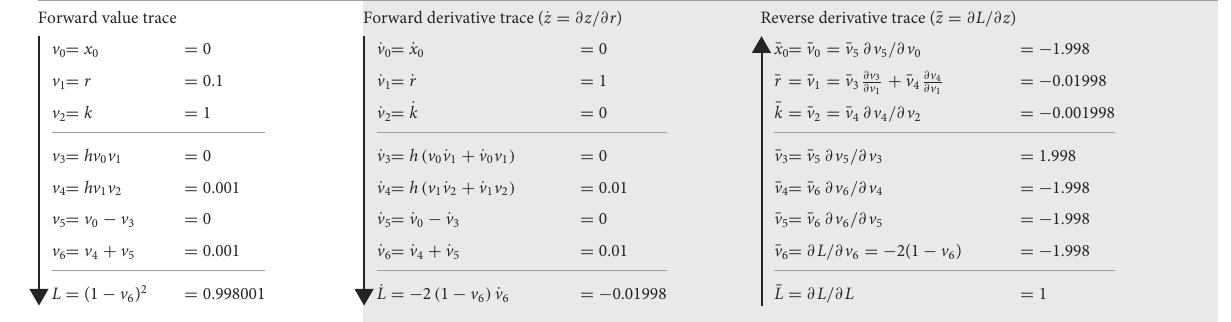
TABLE 1 Calculations through the computational graph in Figure 1.